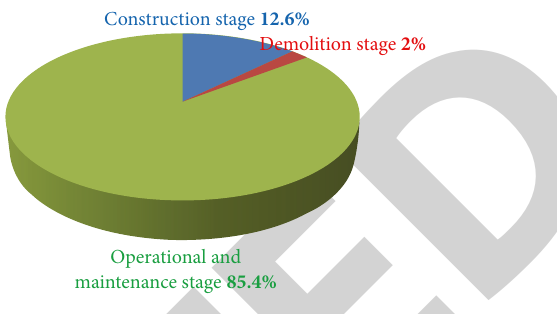
Figure 5: Percentage of CO 2 emissions produced in building life